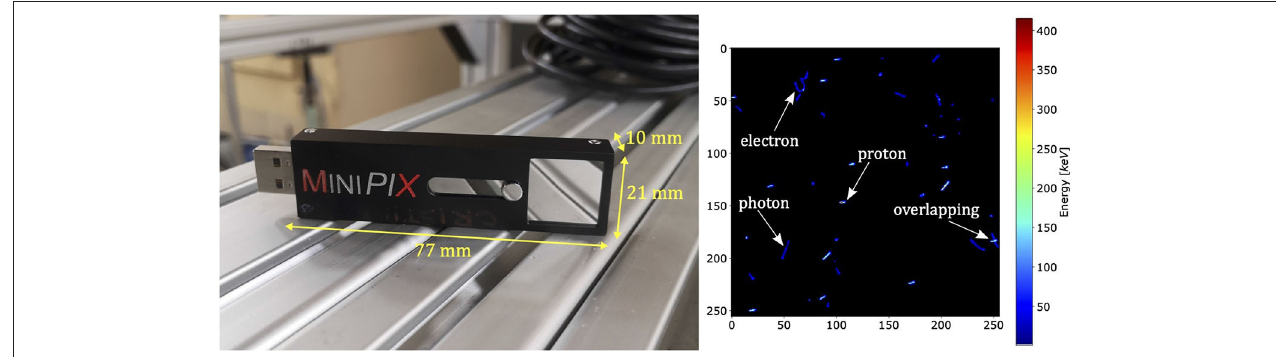
FIGURE 1 | The M INI P IX T IMEPIX detector equipped with a TIMEPIX ASIC and 300 µ m thick silicon sensor (left) and an example frame obtained from the measurements (right) . Clusters are produced by different particles in mixed radiation field of proton pencil beam in water. Low-LET narrow, curly tracks are typical for electrons, high-LET wide, straight tracks for energetic heavy charged particles such as protons, and low-LET straight tracks are characteristic for photons. In the right side of the frame, an example of overlapping clusters is